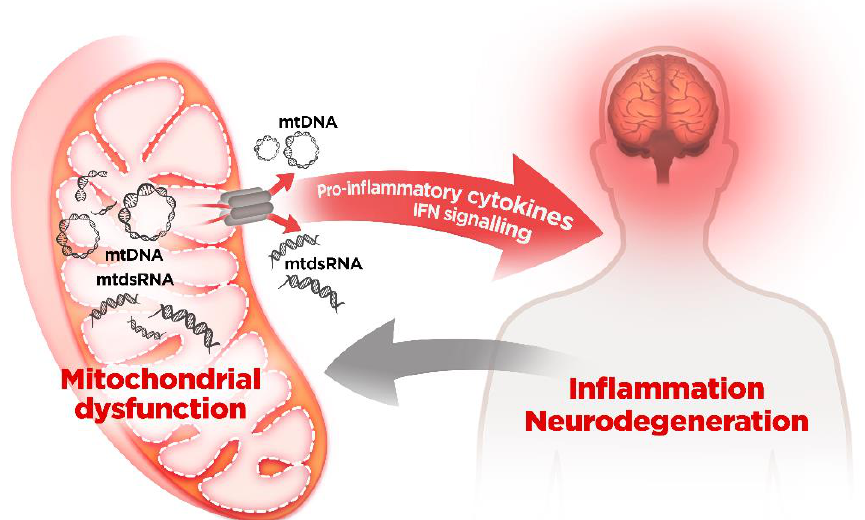
Figure 4. Mitochondrial nucleic acids-driven inflammation as a critical regulator of disease pro- gression in neurodegenerative processes. Dysregulation of mitochondrial function leads to the activation of type I IFN signaling by mt-derived nucleic acids. The activation and the propaga- tion of the inflammatory response may contribute to secondary damage and neurodegeneration. Besides mitochondrial dysfunction promoting inflammation, inflammation per se can lead to mito- chondrial dysfunction, suggesting the existence of a pro-inflammatory loop with mitochondria as a central